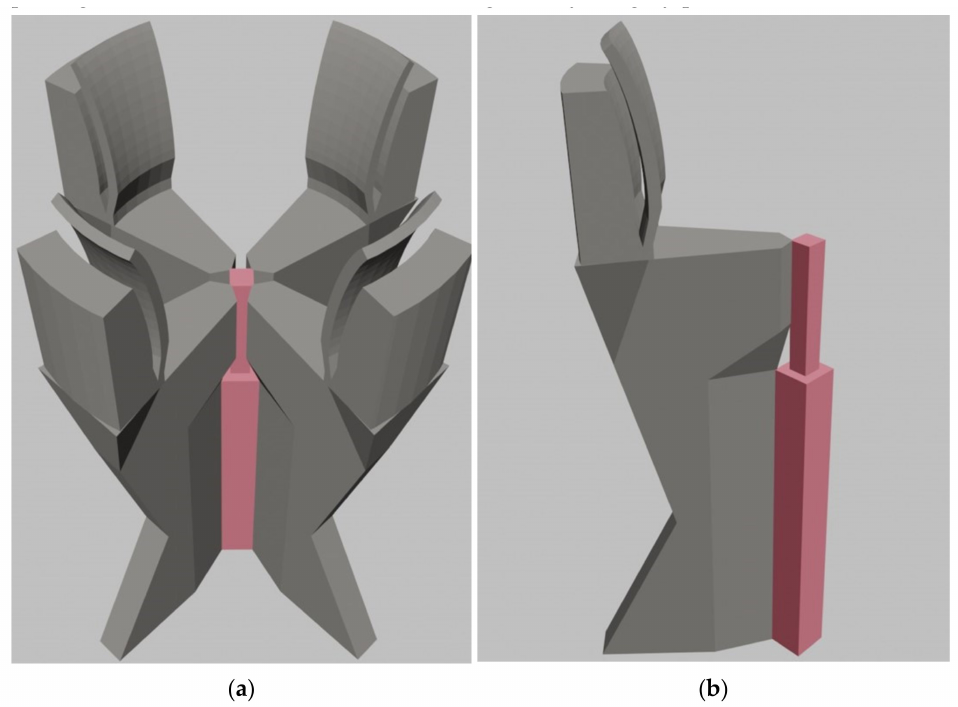
Figure 4. Three-dimensional MMI splitter design: ( a ) whole construction with mechanical clamps for SMF fixation (grey parts); ( b ) 3D view of partly revealed supporting mechanical structure (grey) together with the optical splitter part